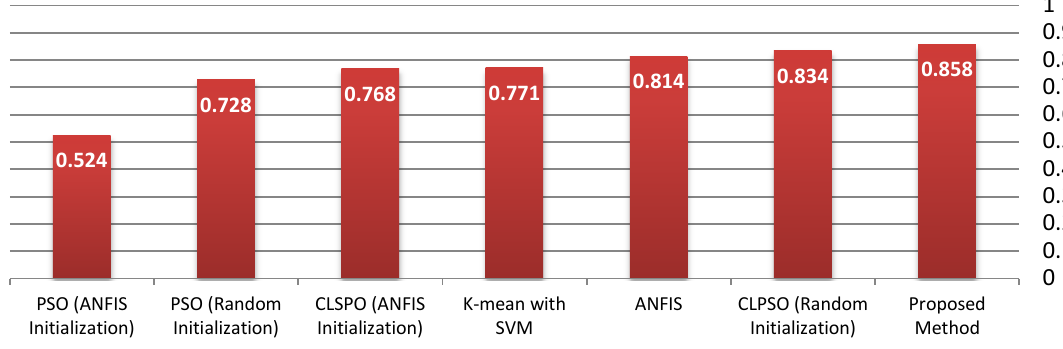
Figure 6. Accuracy of the existing methods.